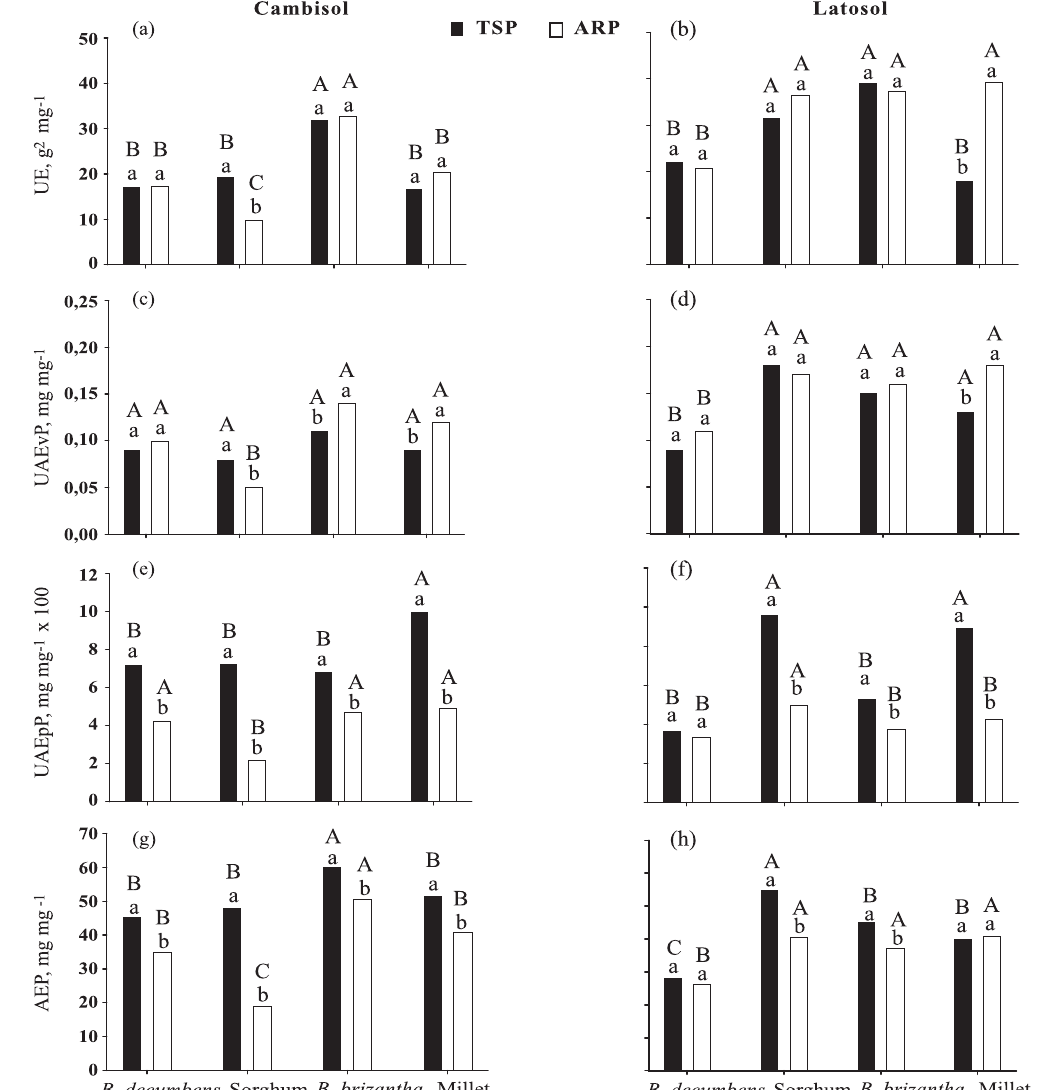
Figure 2. Use efficiency of P (UE) (a and b), use efficiency of available P (UEAvP) (c and d), use efficiency of applied P (UEApP) (e and f) and agronomic efficicency of P (AEP) (g and h) of Brachiaria decumbens , sorghum, Brachiaria brizantha and millet, fertilized with super triple phosphate (TSP) and Arad reactive phosphate (ARP) on a Cambisol and a Latosol. Means did not differ from each other when followed by the same lower-case letter for both soils, in the comparison of P sources for each forage grass, and upper-case letters, in the comparison of forage grasses for each P source (Scott Knott 5